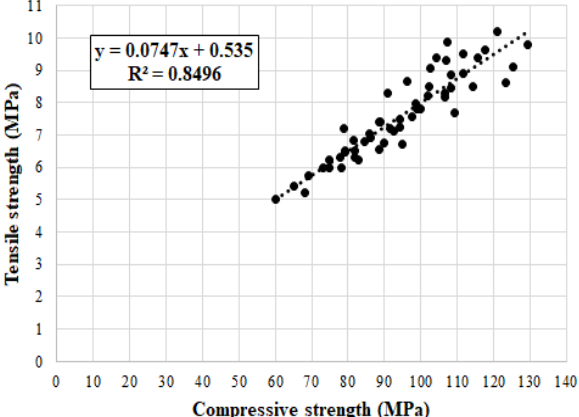
Figure 12. Compressive – tensile strength relationship of SF reinforced HSC containing NS and SP.